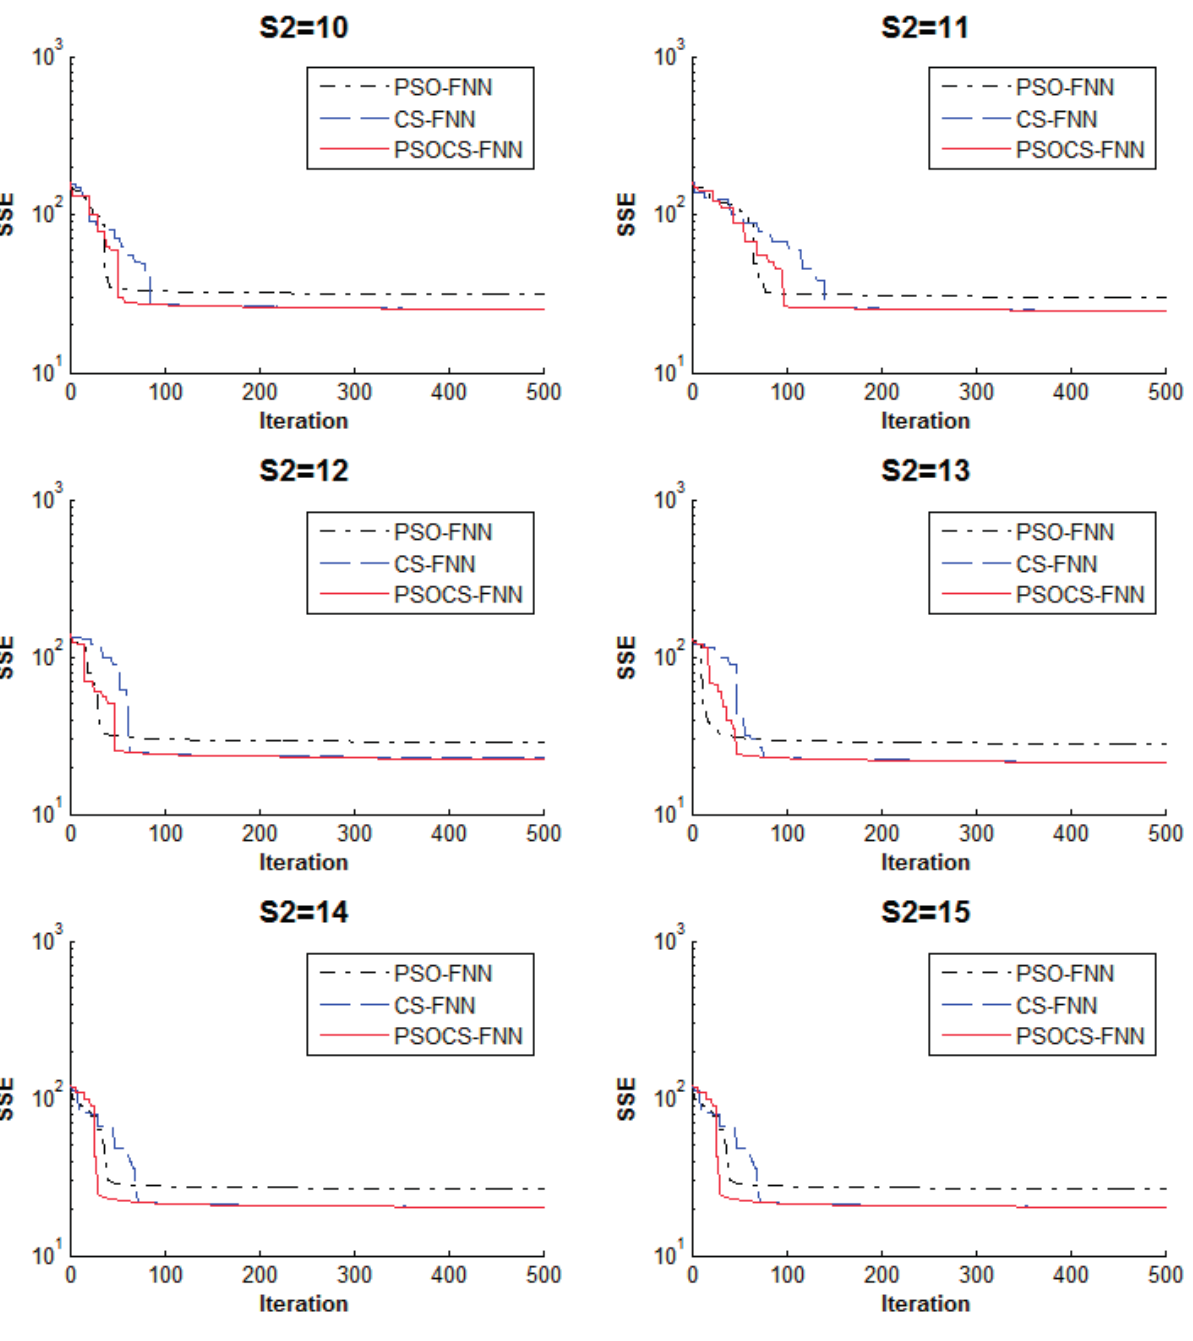
Figure 5. Convergence of PSO-FNN, CS-FNN, and PSOCS-FNN in the Iris classification problem with S 2 = 10, 11, 12, 13, 14, and